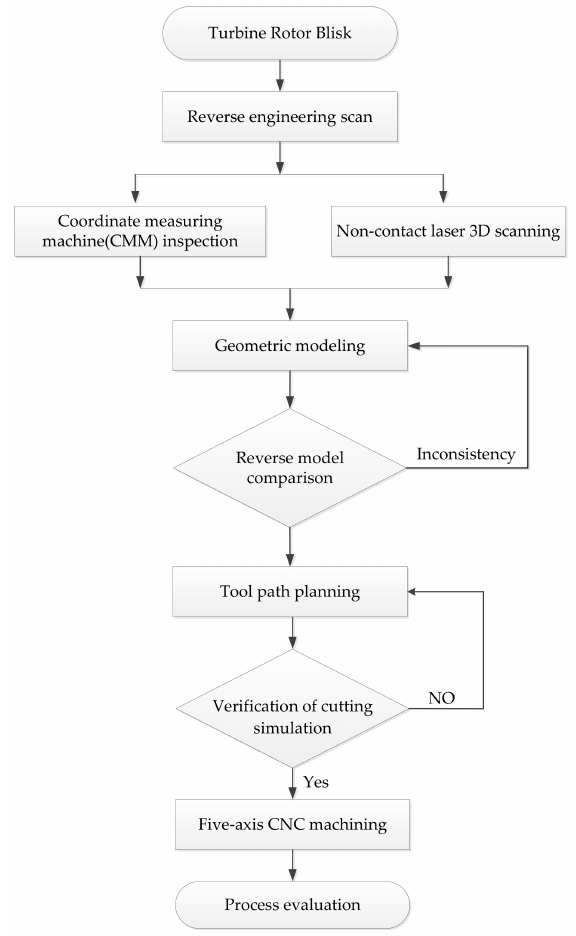
Figure 1. Flowchart of the research